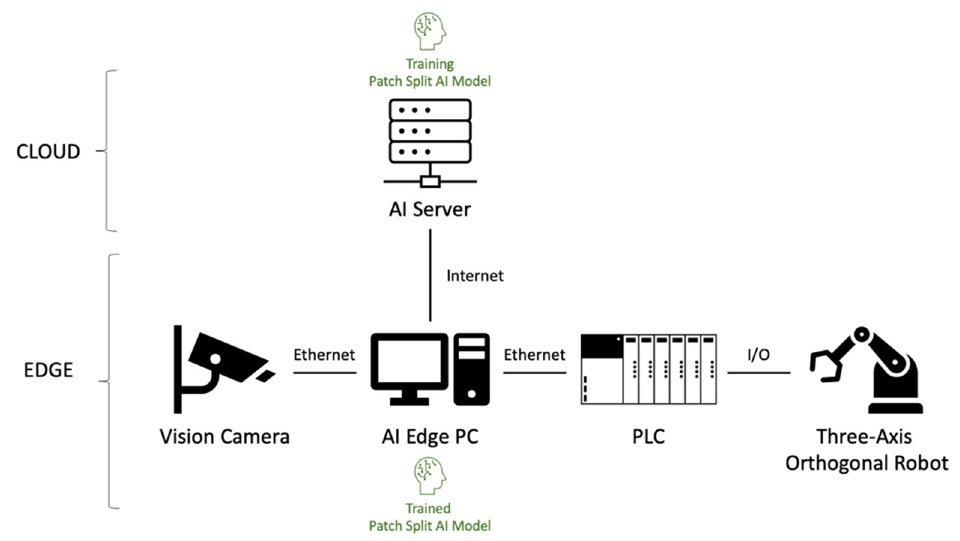
Figure 10. Implemented systems for data acquisition, model training, and inference.